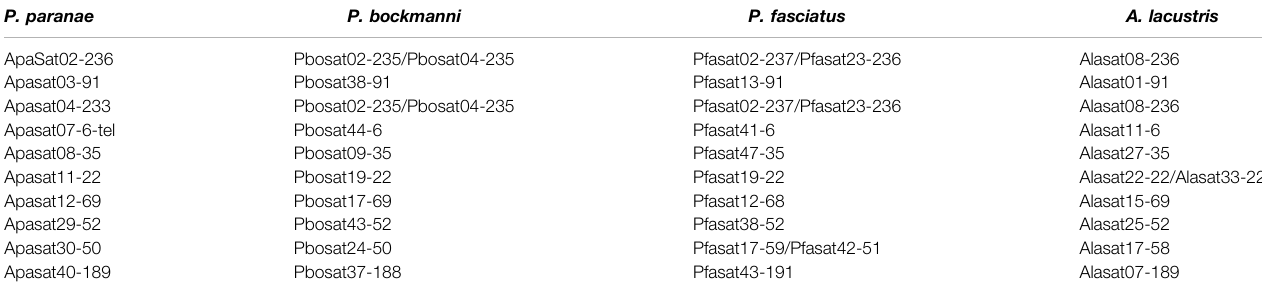
TABLE 5 | SatDNA families with at least 50% of similarity in three species of Psalidodon and one species of Astyanax .